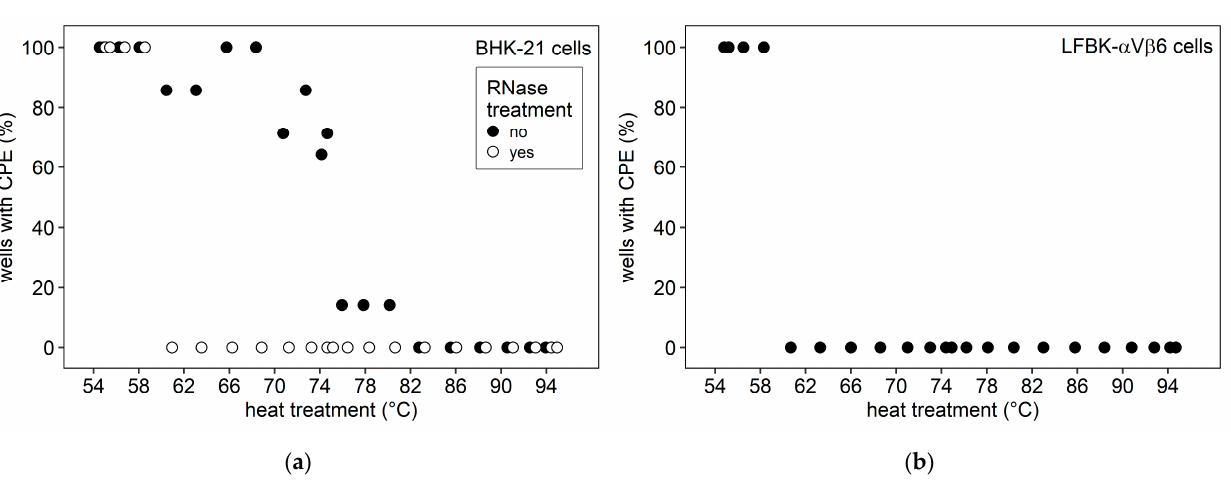
Figure 1. Inoculation of cell cultures with heat-treated FMDV. For each treatment temperature, the percentage of replicate wells that developed CPE 72 h after inoculation with the previously heated virus suspension is shown: ( a ) heat-inactivated virus preparation on BHK-21 cells, with and without RNase treatment after heating; ( b ) heat-inactivated virus preparation on LFBK- α V β 6 cells.